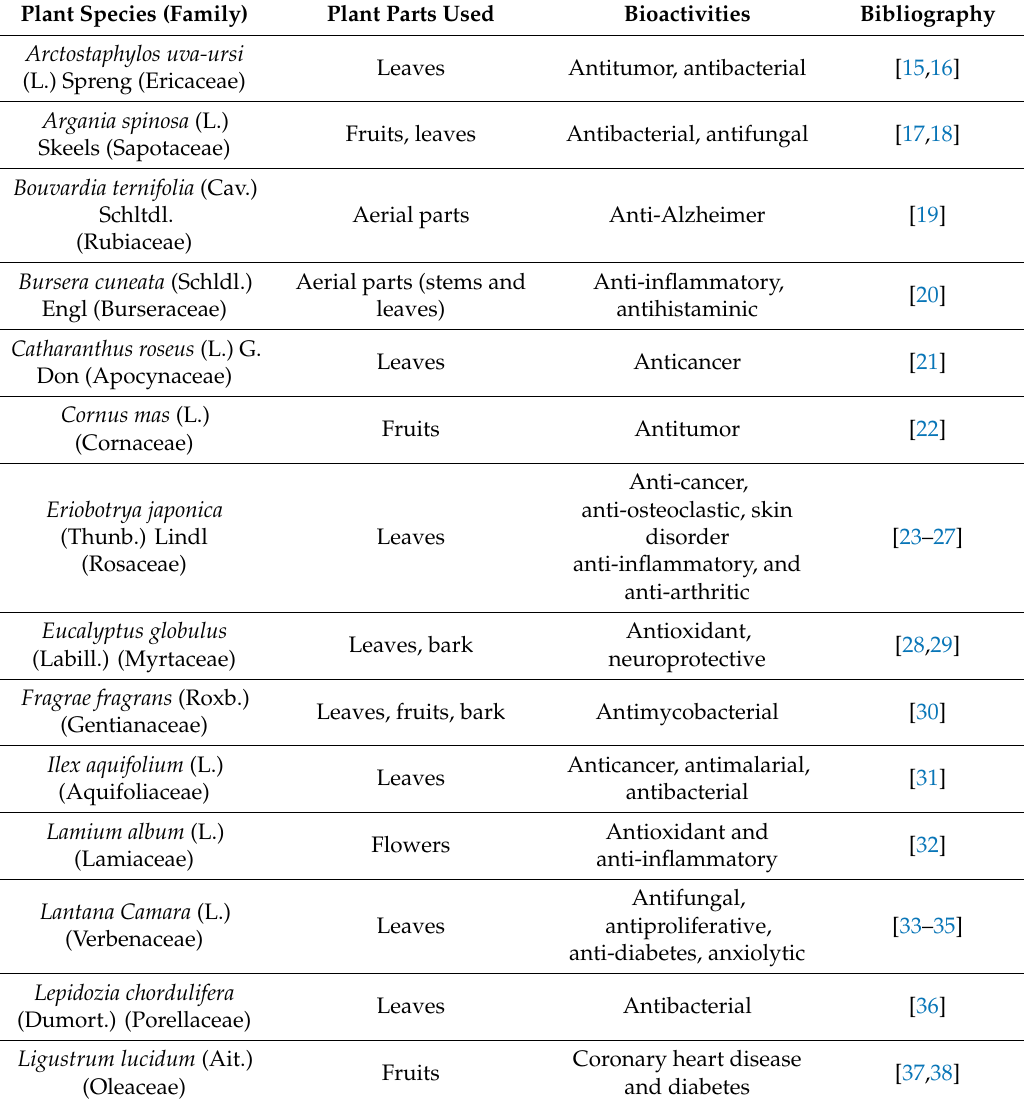
Table 1. Several plant species with (ursolic acid) UA